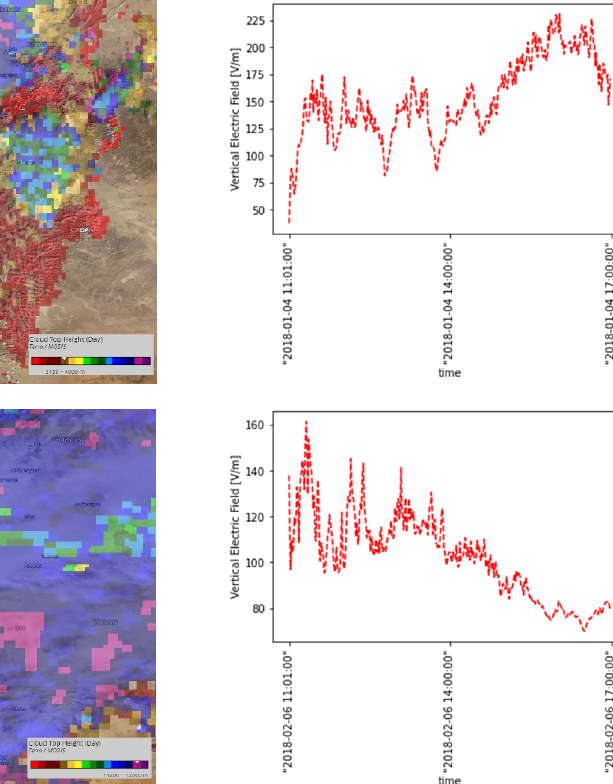
Figure 1. Data for two case studies: 4 January 2018 ( top ) and 6 February 2018 ( Bottom ). In each row: ( left ) Satellite image of clouds above Israel in visible light. ( center ) Measured cloud top height by Terra MODIS with colors indicating approximate height. ( right ) Observed PG values at ground level in Mitzpe Ramon.